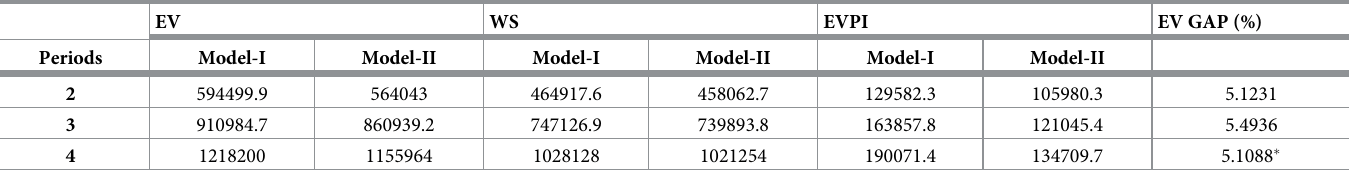
Table 7. Comparison between Model-I and Model-II with respect to the importance indicators of stochastic optimization, “ � ” indicates approximation. Own elaboration. EV WS EVPI EV GAP (%) Periods